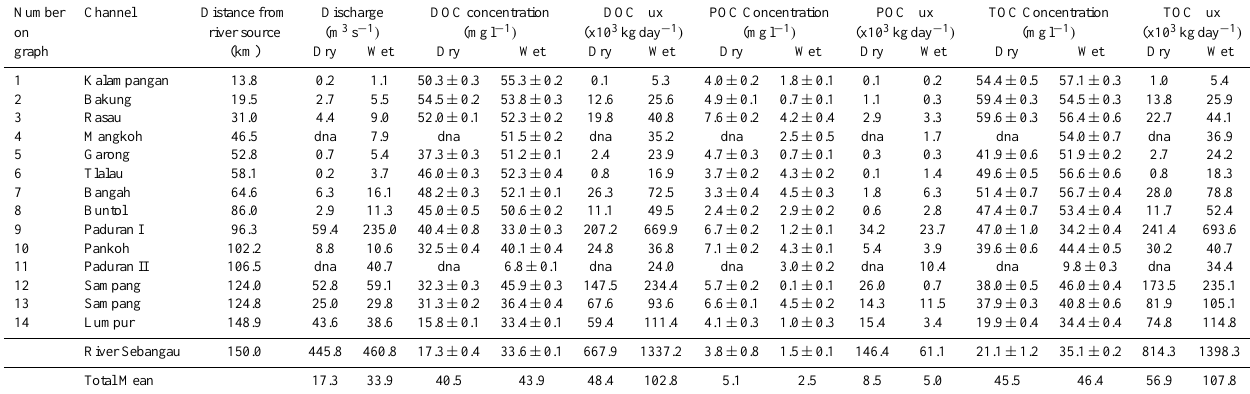
Table 1. Mean discharge, DOC, POC and TOC concentrations ( ± s.e.) and fluxes (s.e. < 1%) from the confluences of 14 channels that discharge into the River Sebangau, during the dry and the wet season in 2008/09. The row titled River Sebangau represents concentrations and fluxes from the River Sebangau to the Java Sea. Total mean includes the 14 channels, but not the River Sebangau